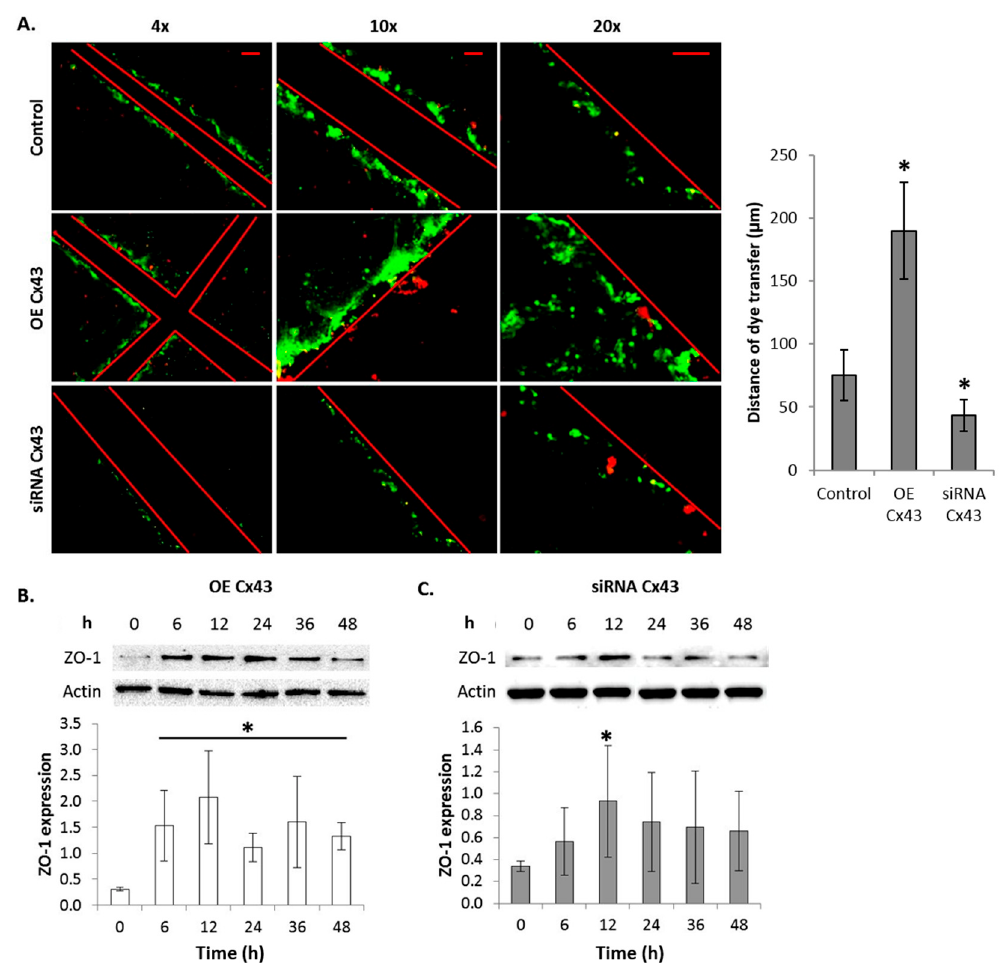
Figure 6. Modulation of connexin 43 expression affects GJIC. ( A ) Gap junction activity of FMC2u determined by scrape load dye transfer after transfection with empty vector (control), GFP-Cx43 cDNA vector, or siRNA Cx43. A graphical representation of dye transfer in µm was shown next to the images. Red lines indicate a cross sectional cut. Lucifer yellow was used as a gap junctional dye and Rhodamine-dextran used to mark the cut site. Green fluorescence indicates the passage of dye form the cutting site. Images taken at 4×, 10×, and 20×. Scale bar = 100, 100, 50 µm, respectively. Graphical representation of ZO-1 expression in Cx43-immunoprecipitated FMC2u cells at 0, 6, 12, 24, 36, and 48 h post transfection; ( B ) Induced overexpression of Cx43 and ( C ) a silencing of Cx43. All experiments conducted with a sample size of n = 3. * p -value < 0.05 compared to respective transfection control.